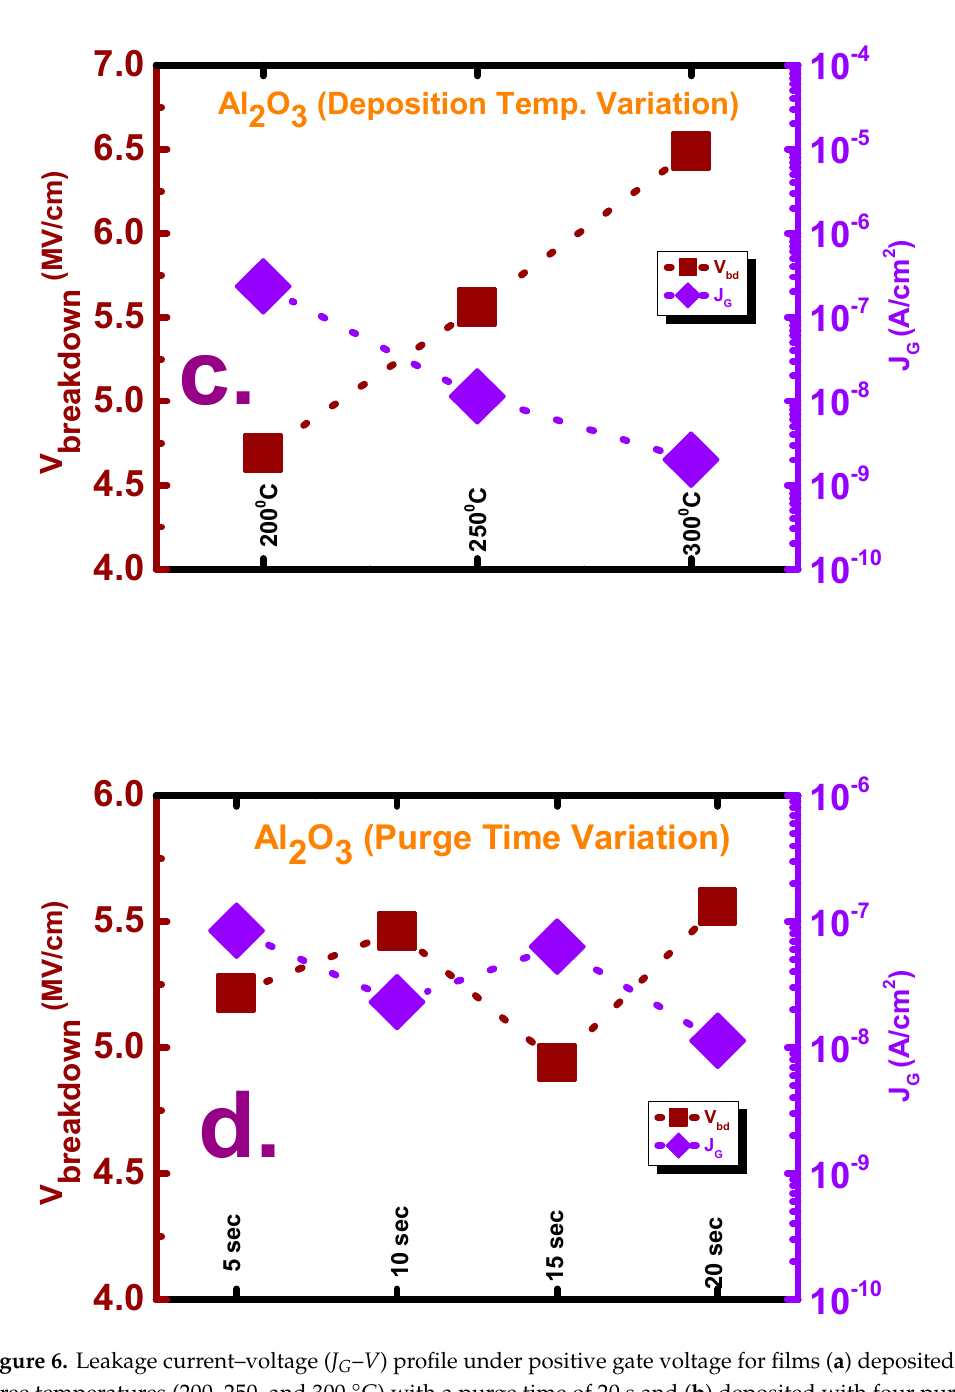
Figure 6. Leakage current–voltage ( J G – V ) profile under positive gate voltage for films ( a ) deposited at three temperatures (200, 250, and 300 ◦ C) with a purge time of 20 s and ( b ) deposited with four purge times (5, 10, 15, and 20 s) at a deposition temperature of 250 ◦ C. Comparison of the breakdown voltage ( V BD ) and leakage current density ( J G ) for films ( c ) deposited at three temperatures (200, 250, and 300 ◦ C) with a purge time of 20 s and ( d ) deposited with four purge times (5, 10, 15, and 20 s) at a deposition temperature of 250 ◦ C.